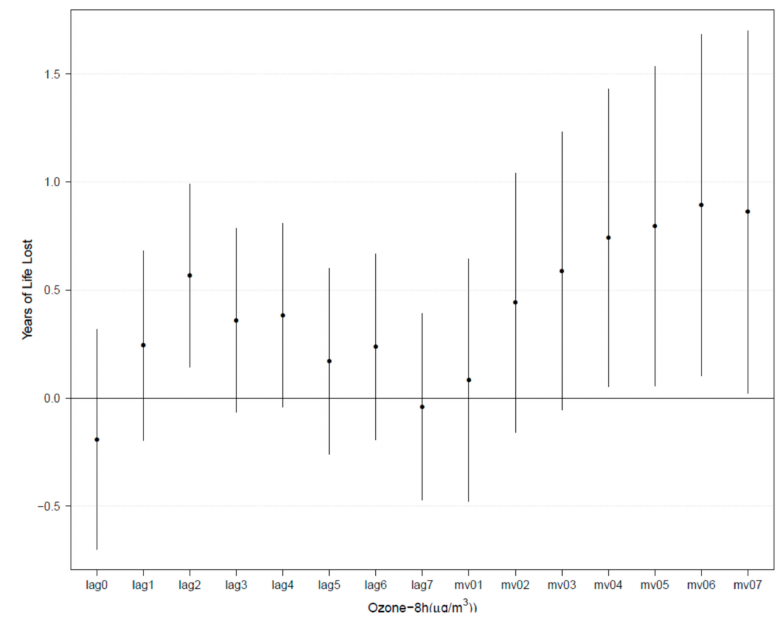
Figure 2. Estimated changes with 95% confidence intervals in years of life lost (YLL) from hypertension associated with each 10 µ g / m 3 increase in ozone on di ff erent lag days in the elderly population in Ningbo, China, from 2013 to